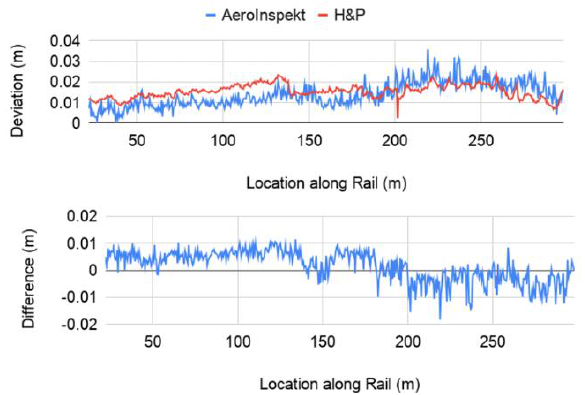
Fig. 10: Top: Deviation from the reference line along the reference axis, blue: our result (AI), red: rail measuring vehicle (H&P), bottom: Difference between the two measurements In Fig. 10 the position is considered first. In the figure above, the blue line shows the deviation from the reference line as a function of the position along the rail, taking into account the distance determined in this project. The red line is the distance calculated by the rail car/track measurement angle. First of all, it is noticeable that the blue line shows much more high-frequency fluctuations than the red line. These quite high fluctuations in the our result from one measuring point to the next - in the given 2m grid - indicate residual uncertainties in the automatic image analysis.